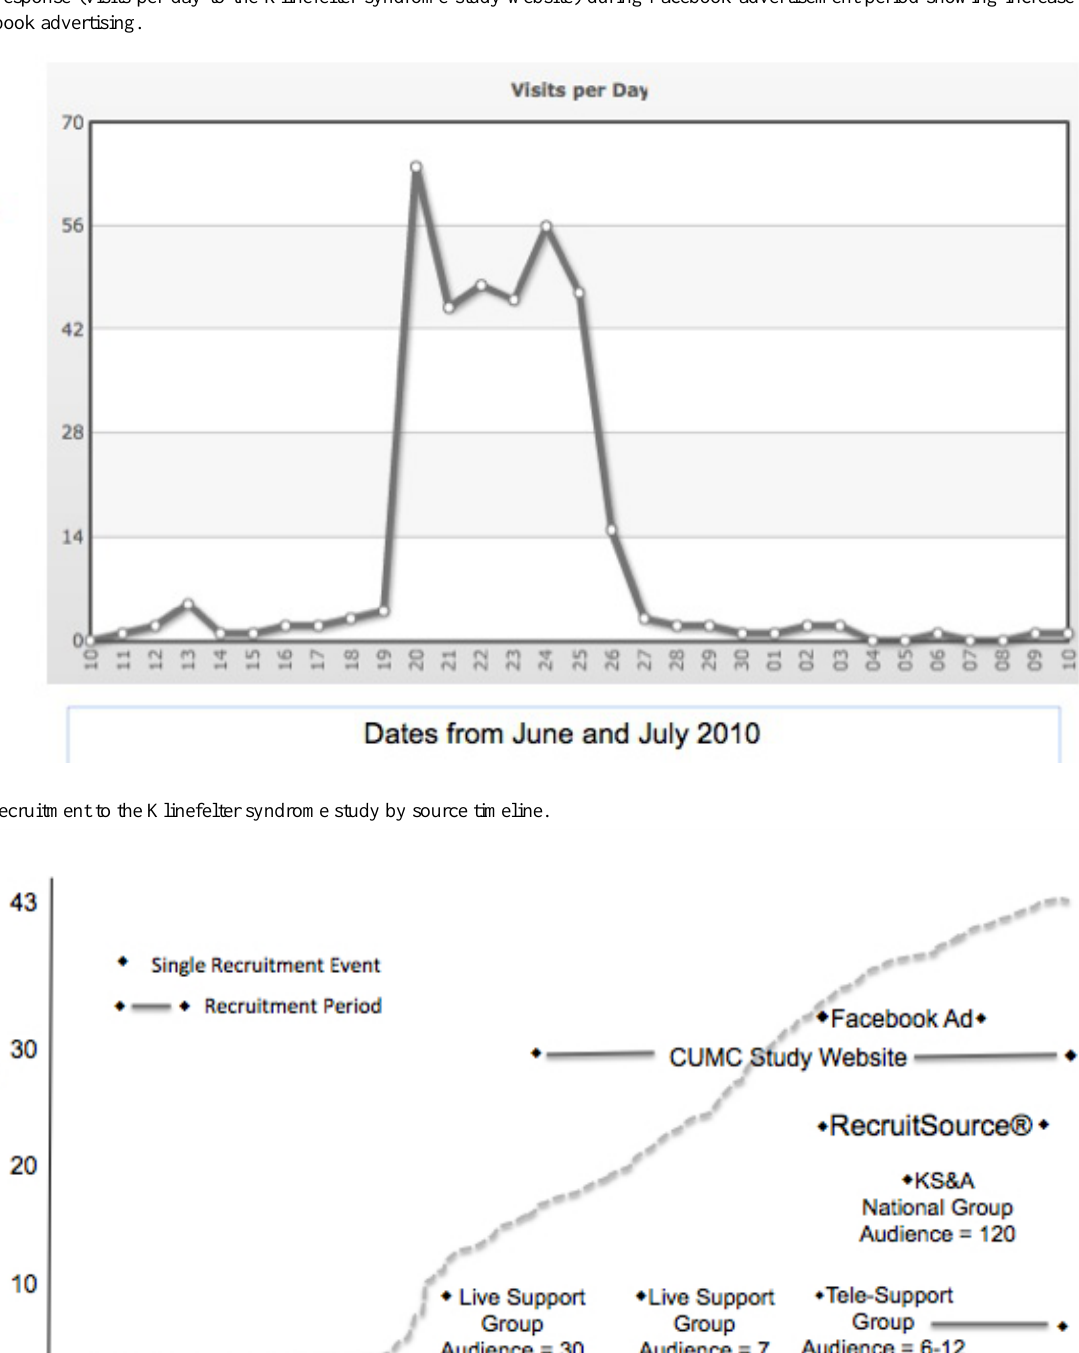
Figure 1. Response (visits per day to the Klinefelter syndrome study website) during Facebook advertisement period showing increase in activity during Facebook advertising.